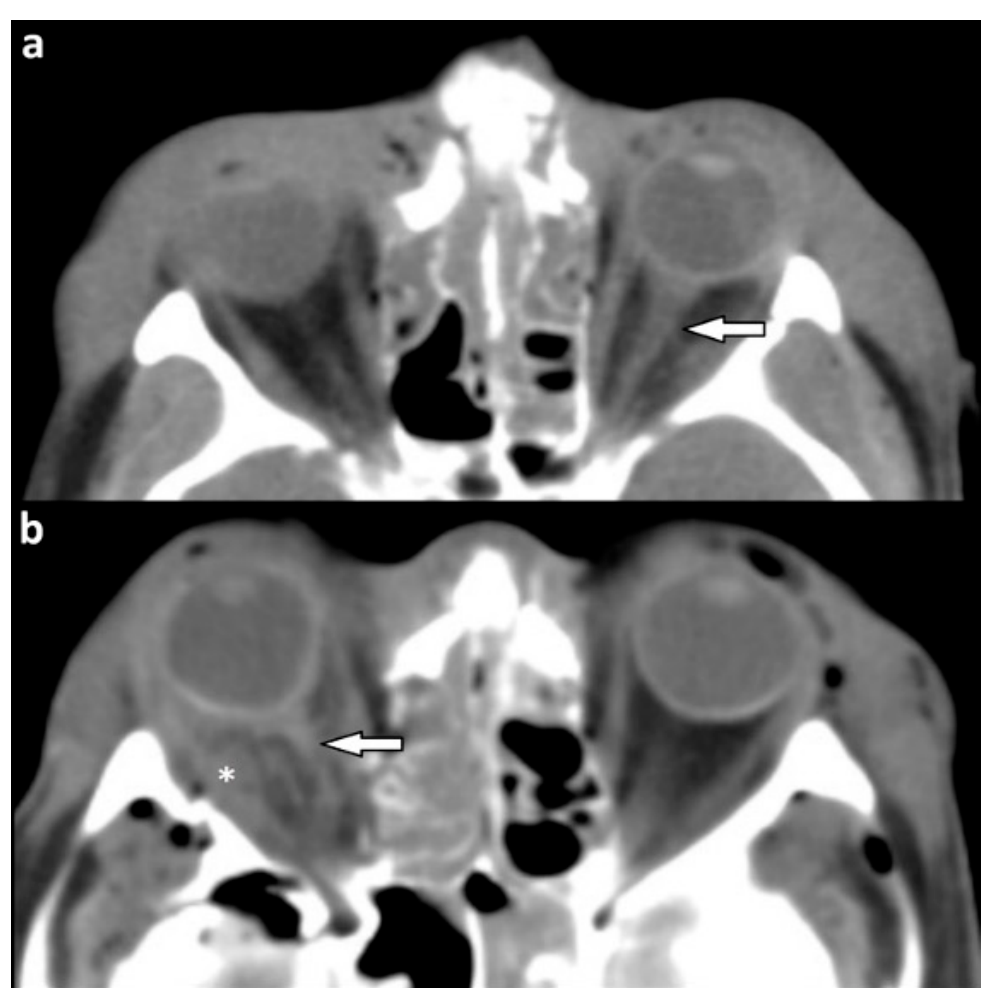
Figure 4. Dislocated left lens (indicated by arrow) and lateral rotation of about 70 degrees. Asterisk (*) indicates periorbital soft tissue emphysema due to a concomitant orbital floor fracture. NE- MSCT, soft tissue window, axial reformation (NE-MSCT = non-contrast-enhanced multi-slice CT). Thirteen patients (12.9%) were diagnosed with an elongation of the optic nerve com- pared to the contralateral side, and in 10 cases (9.9%), its shape was otherwise altered (Figure 5).